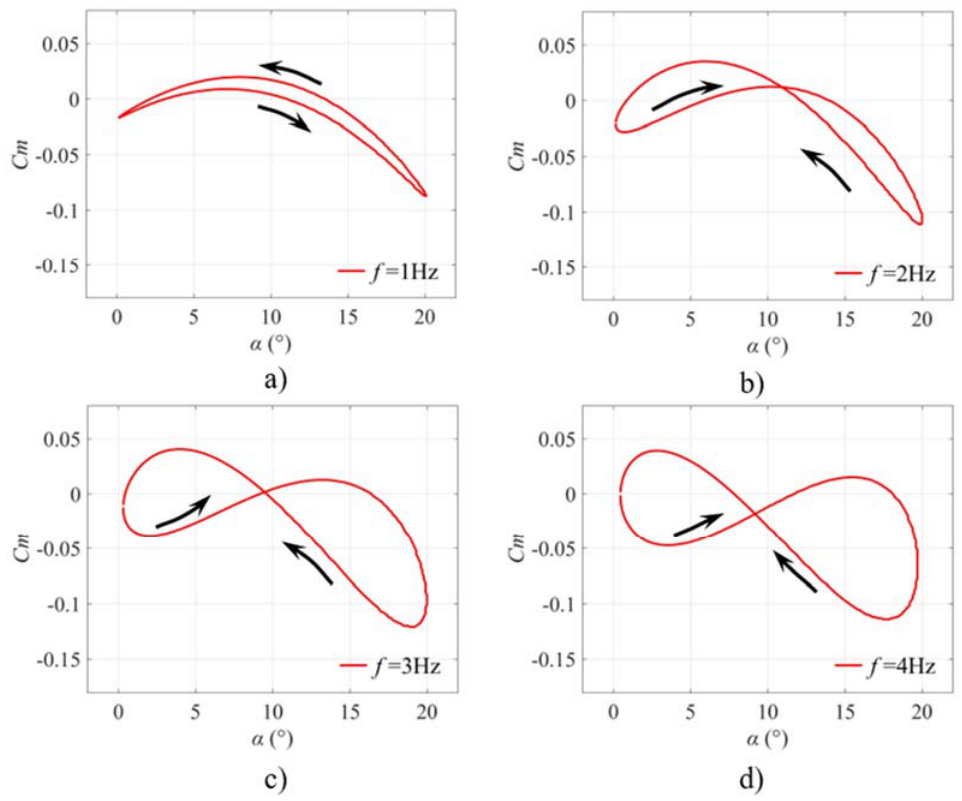
Figure 5. Phase-averaged moment coefficient ( Cm ) for ( a ) f = 1 Hz, ( b ) f = 2 Hz, ( c ) f = 3 Hz, and ( d ) f = 4 Hz for the oscillating airfoil.